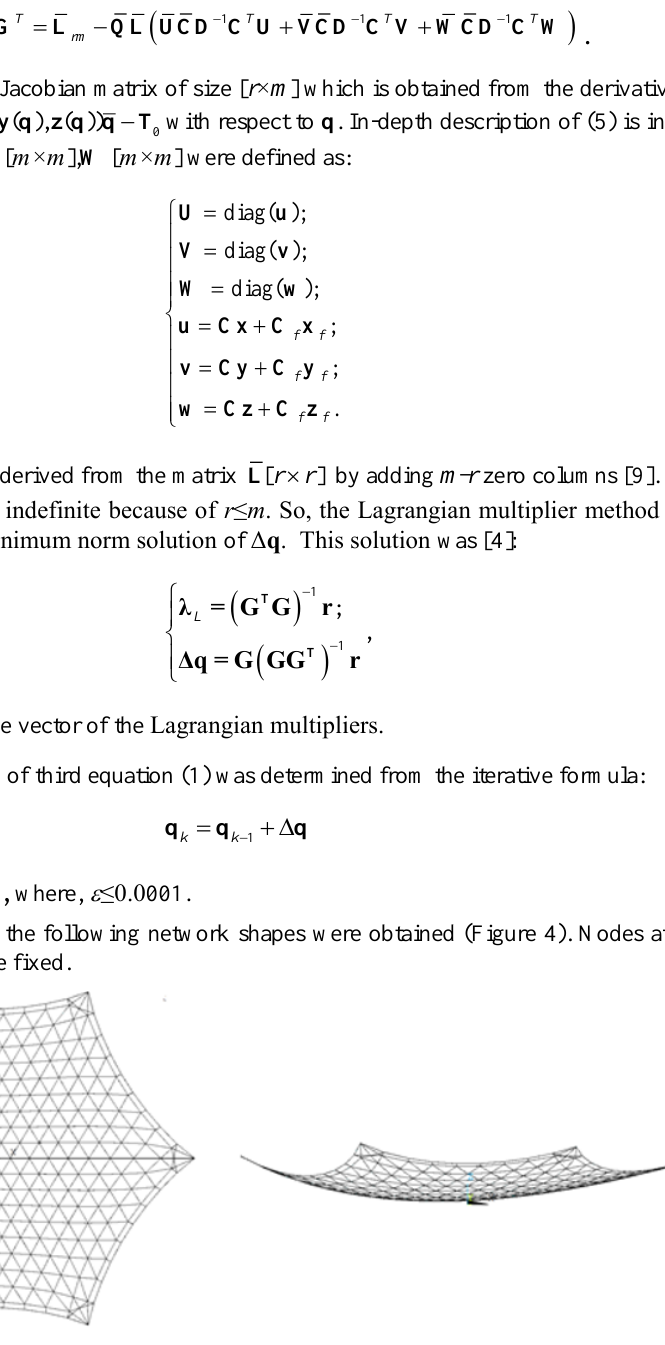
Fig. 4. Calculated reflector frontal (rear) network shapes